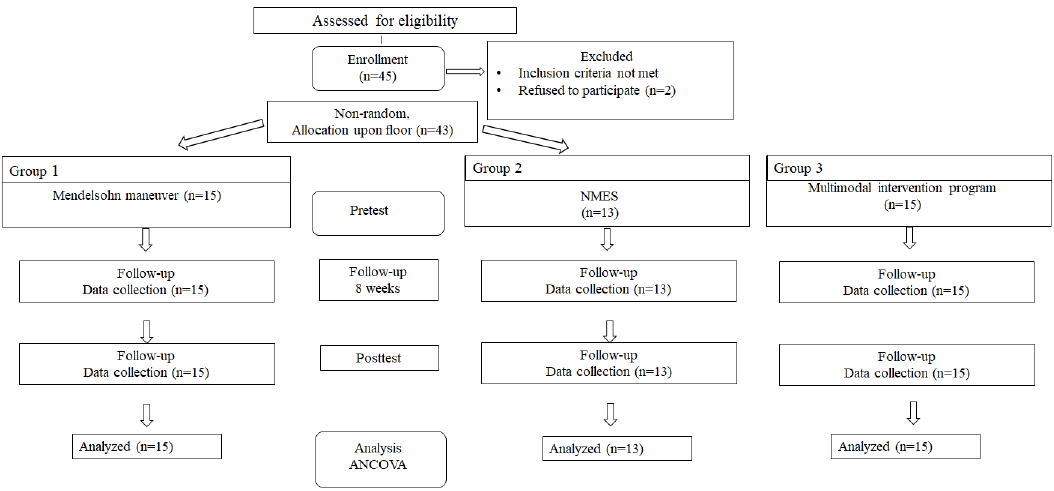
Figure 1. The schematic diagram of the study. Table 1. Baseline characteristics of subjects, M ± SD.